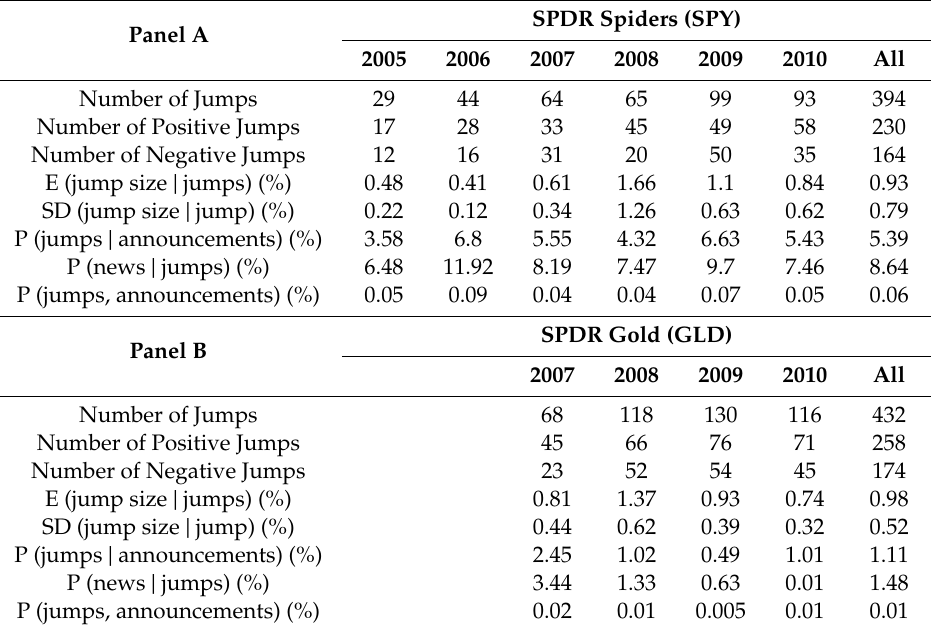
Table 2. Descriptive statistics of intraday